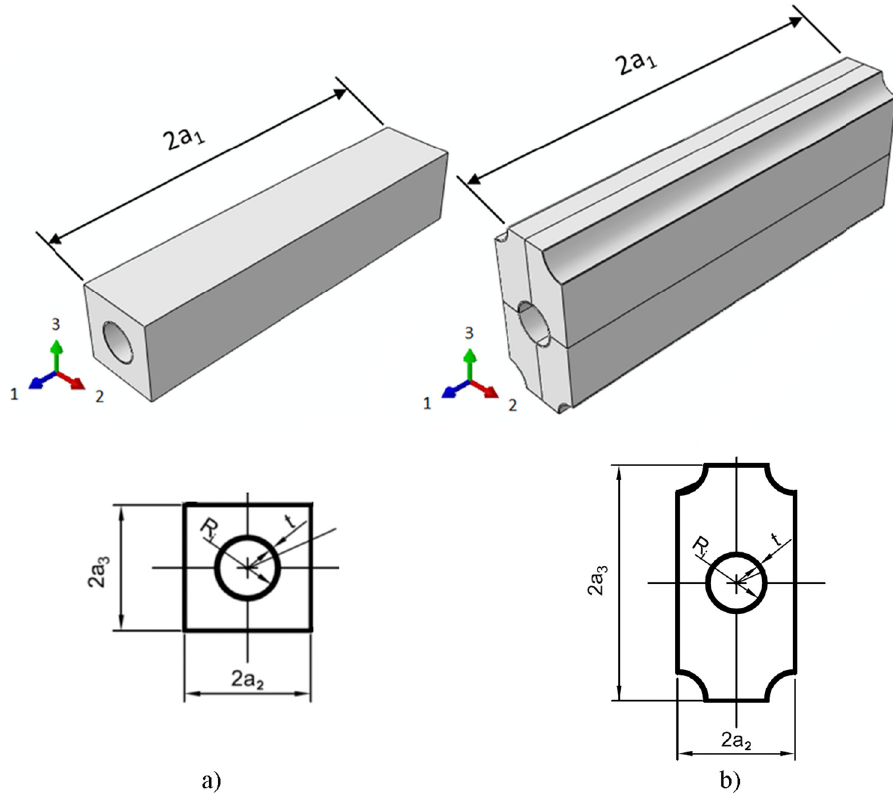
Figure 3: Representative volume element: ( a ) square array and ( b ) hexagonal array.